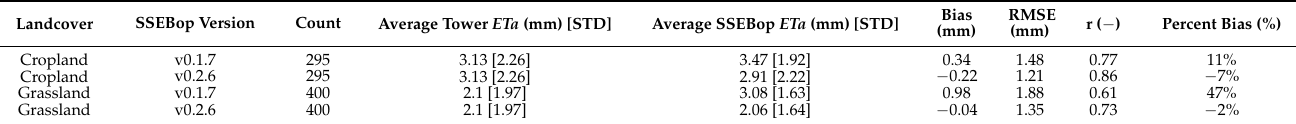
Table 6. Overpass actual ET ( ETa ) comparison between SSEBop and flux tower categorized by landcover (as reported by Ameriflux). SSEBop was forced with the climatology Gridmet 1981–2010 ETr without any scaling